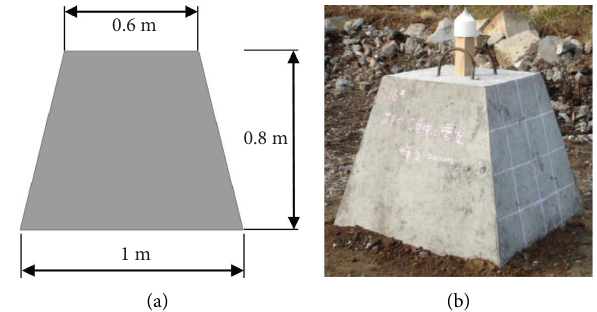
Figure 3: Structure of the concrete pile. (a) Dimensions of concrete piles. (b) Concrete